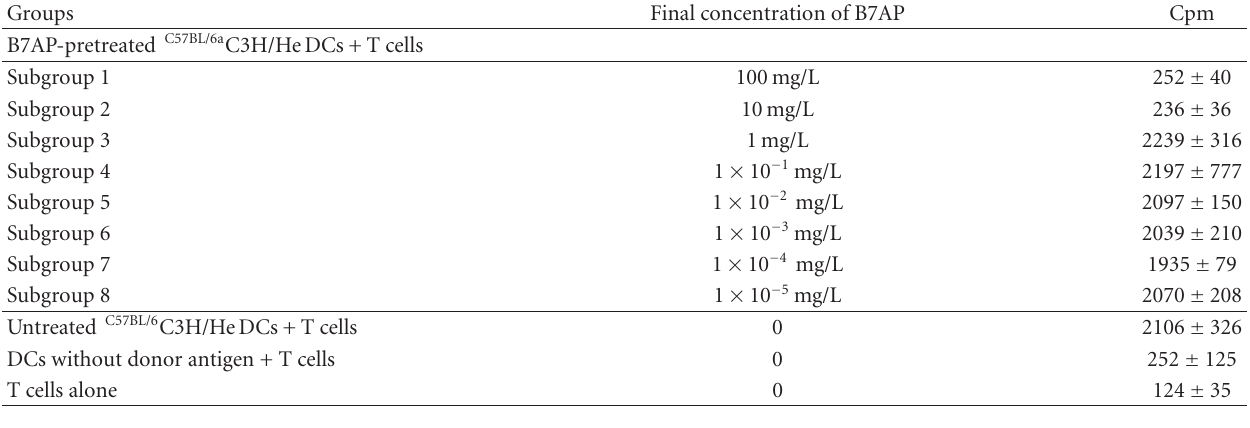
Table 1: MLR of T cells and recipient DCs with di ff erent treatment.